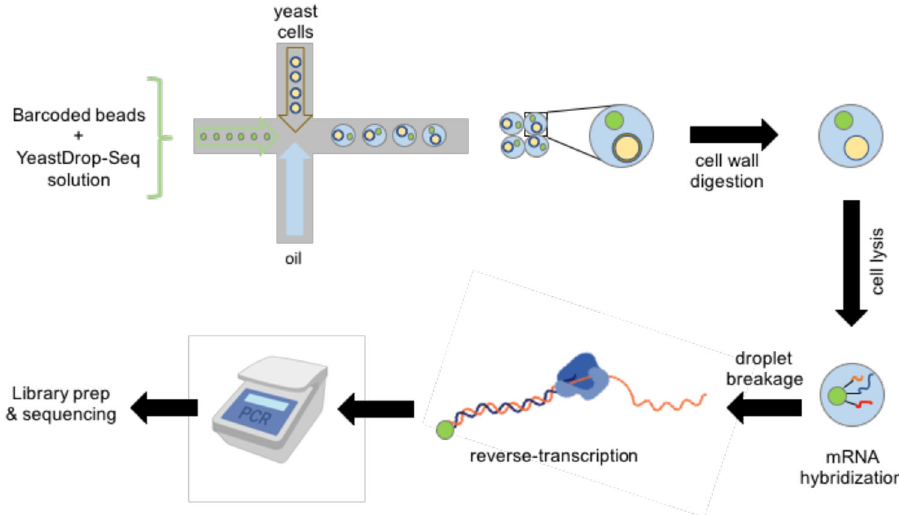
Fig. 1 A schematic of the single-cell mRNA sequencing work fl ow for transcriptomic analysis of yeast cells. The yeastDrop-Seq solution containing chemicals for cell-wall digestion and cell lysis is mixed with barcoded microbeads, and the mixture is fl own through one inlet of a micro fl uidic device. Yeast cells with intact cell walls and oil are fl own through the second and third inlet of the micro fl uidic device, respectively. Encapsulated cells are then incubated to allow for cell-wall breakage and lysis. mRNA molecules hybridize to the barcoded microbeads via their polyA tails, droplets are broken, and reverse transcription occurs. cDNA is PCR-ampli fi ed and the cDNA libraries are prepared and submitted for